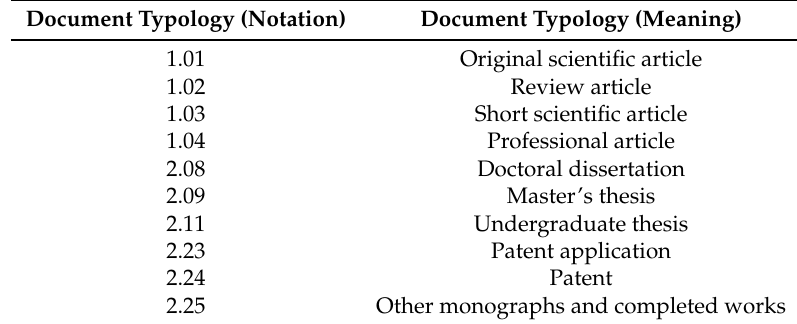
Table 1. Examples of document typologies and their metadata notation. Full typology is available in